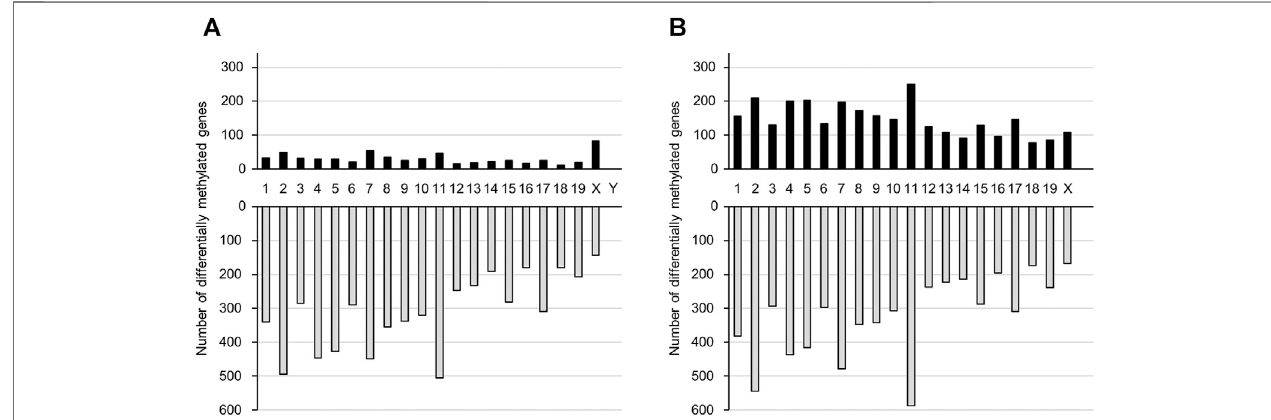
FIGURE 2 | The number of genes that show altered DNA methylation states following prenatal TiO 2 -NP exposure. Number of genes presenting altered DNA methylationstates betweenShamand